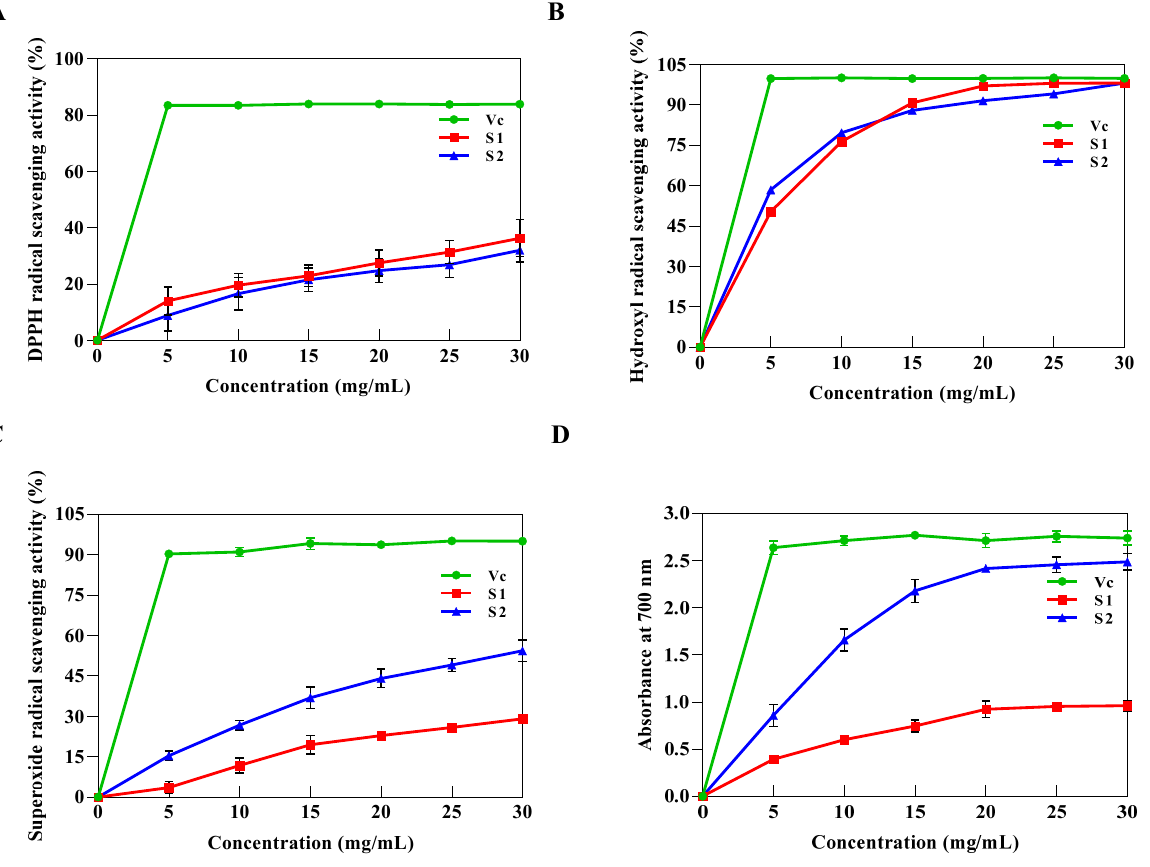
Figure 8. Antioxidant activities of S1 and S2. ( A ) DPPH scavenging activity, ( B ) hydrogen peroxide scavenging activity, ( C ) superoxide radical scavenging activity, ( D ) reducing power.